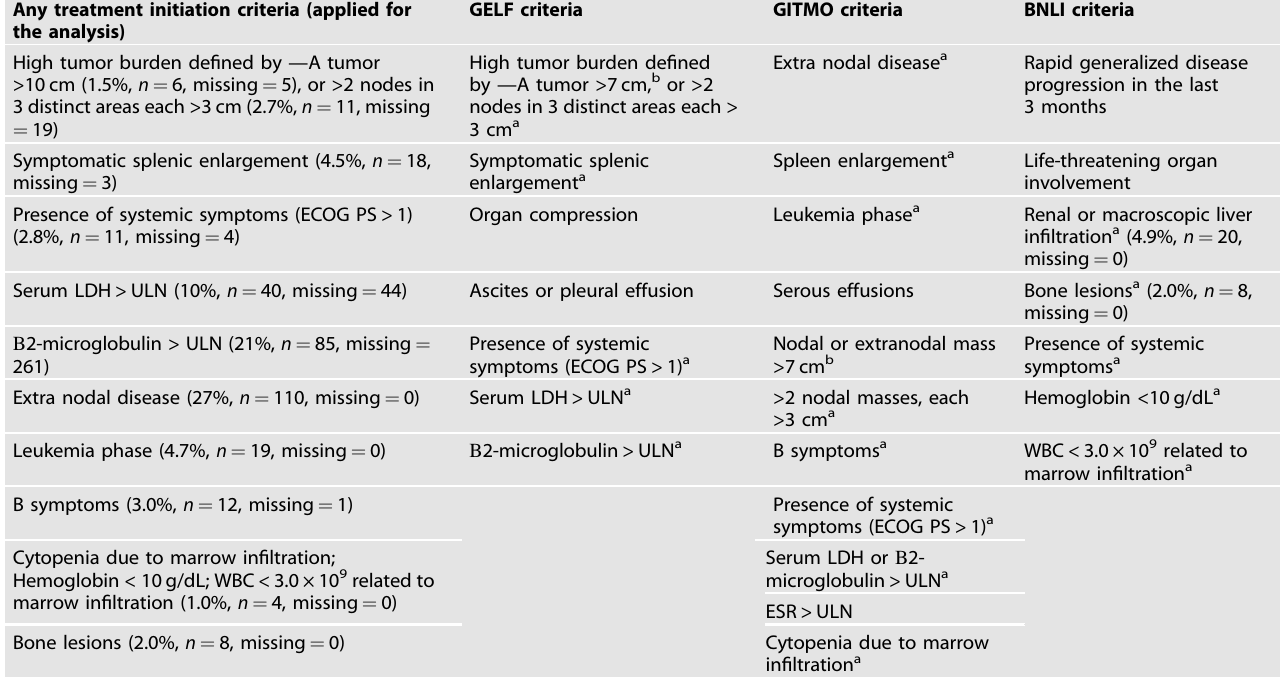
Table 3. Derivation of treatment initiation criteria and components of GELF, BNLI, and GITMO criteria available in MER database. Any treatment initiation criteria (applied for the